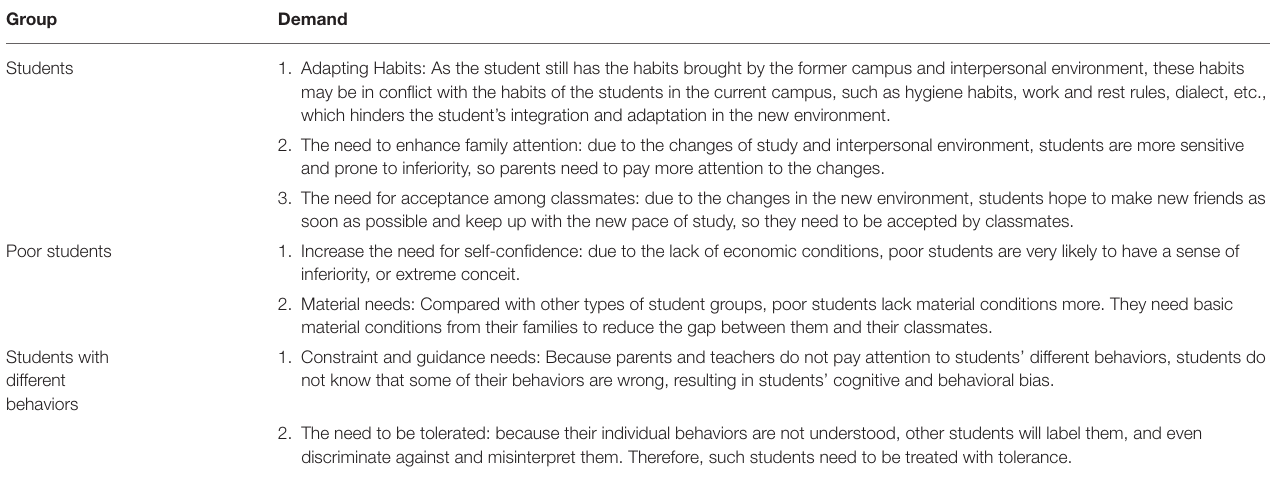
TABLE 2 | Special group services and needs